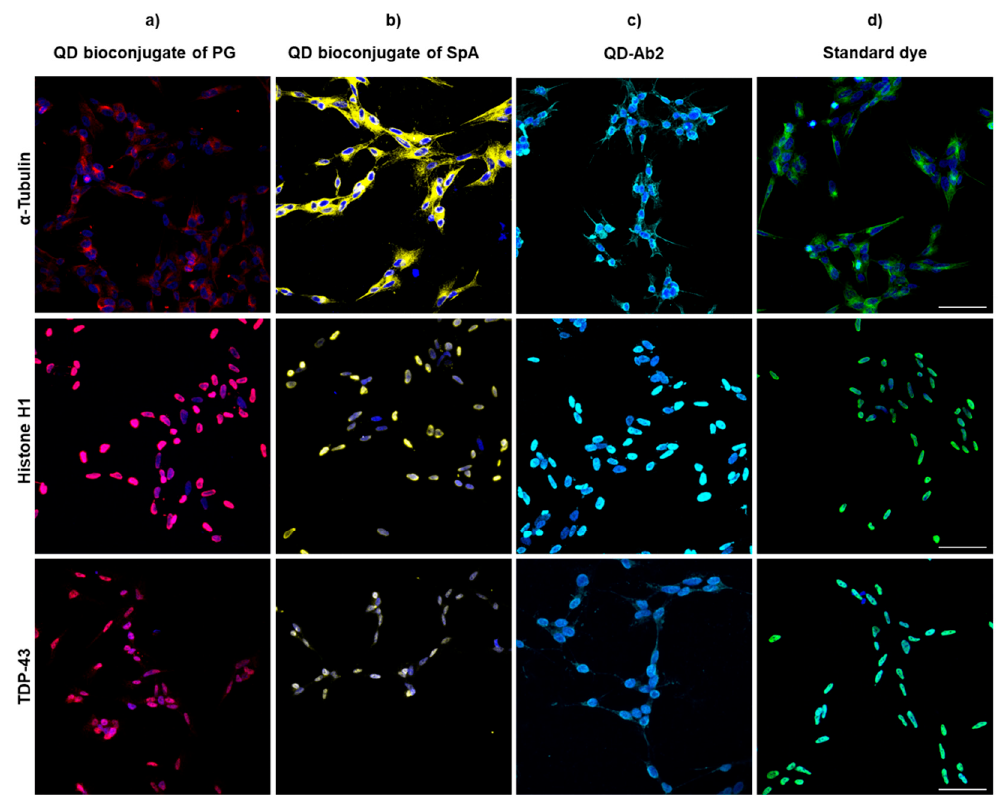
Figure 6. Staining of different commercially available QD conjugates and classic IF. α - Tubulin, Histone H1 and TDP-43 were stained in a one-step protocol with ( a ) QD655 bioconjugate of PG incubated with primary antibody ( b ) QD605 bioconjugate of SpA incubated with primary antibody; or in a two-step protocol with ( c ) QD655-Ab2 after primary antibody incubation and ( d ) standard dye after primary antibody incubation. To label cytoplasmic targets Triton 0.25% was used as permeabilization agents in all cases. For nuclear targets further permeabilization was needed using Triton 0.25% and DTAC 2% for QD bioconjugates and PK 30 µg/mL for QD-Ab2. A standard dye was used as control of no protein degradation. Nuclei were stained with HCS Nuclear Mask Deep Red. Scale bar: 20 µm.